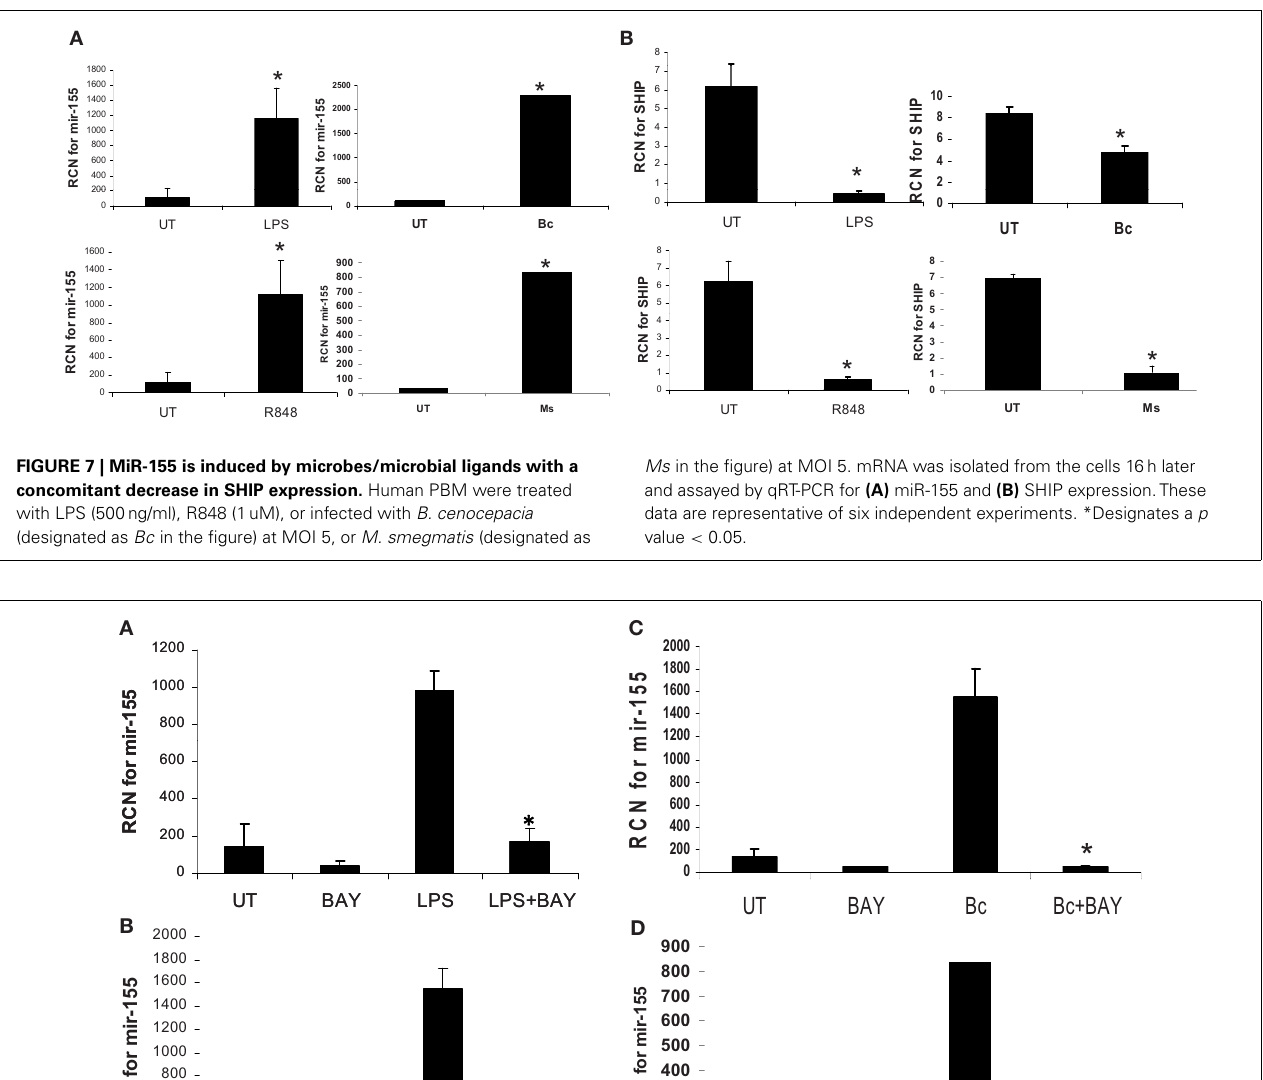
FIGURE 8 | MiR-155 induction by microbes/microbial ligands is NF- κ B-dependent. (A–D) Human PBM were pre-treated with or without the NF- κ B inhibitor (BAY-11-7085, designated as BAY in the figure), and subsequently treated with (A) LPS (500ng/ml), (B) R848 (1uM), or infected